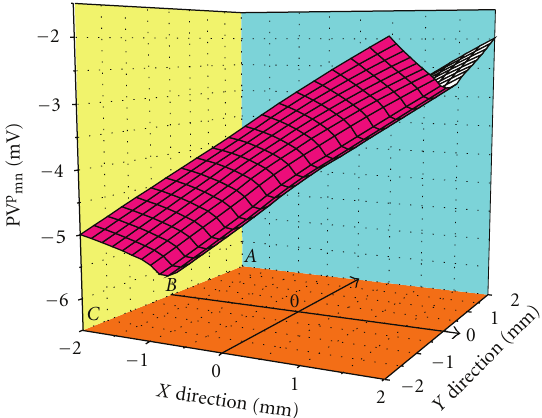
Figure 4: Three-dimensional plot for the PV p mn as a function of the laser spot